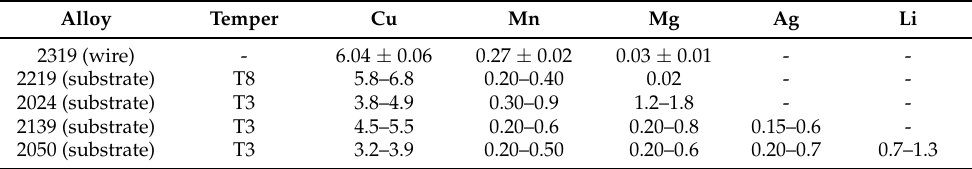
Table 1. Composition of the alloys used as wire and substrates. The chemical composition of the wire was measured using Energy Dispersive X-ray Spectroscopy, and the chemical composition of the substrates was provided by the Aluminium Association [28].